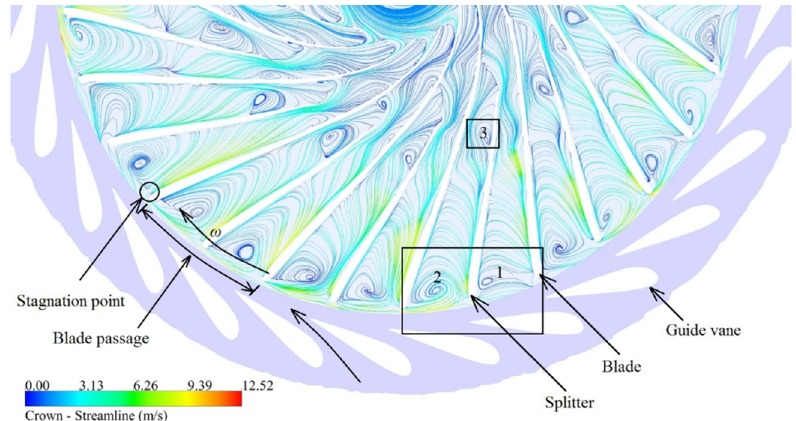
Figure 15. Flow streamlines near the crown surface at the runaway operating condition ( α = 9.9), where the velocity distribution shown is in the rotating frame of reference; ω corresponds to the direction of the runner angular movement, i.e. , clockwise; Points 1, 2 and 3 show the vortical flow regions in a blade passage; the runner includes 15 blades and 15 splitters; n = 8.74 Hz, Q = 0.08 m 3 ∙ s − 1 , H = 12.27 m.